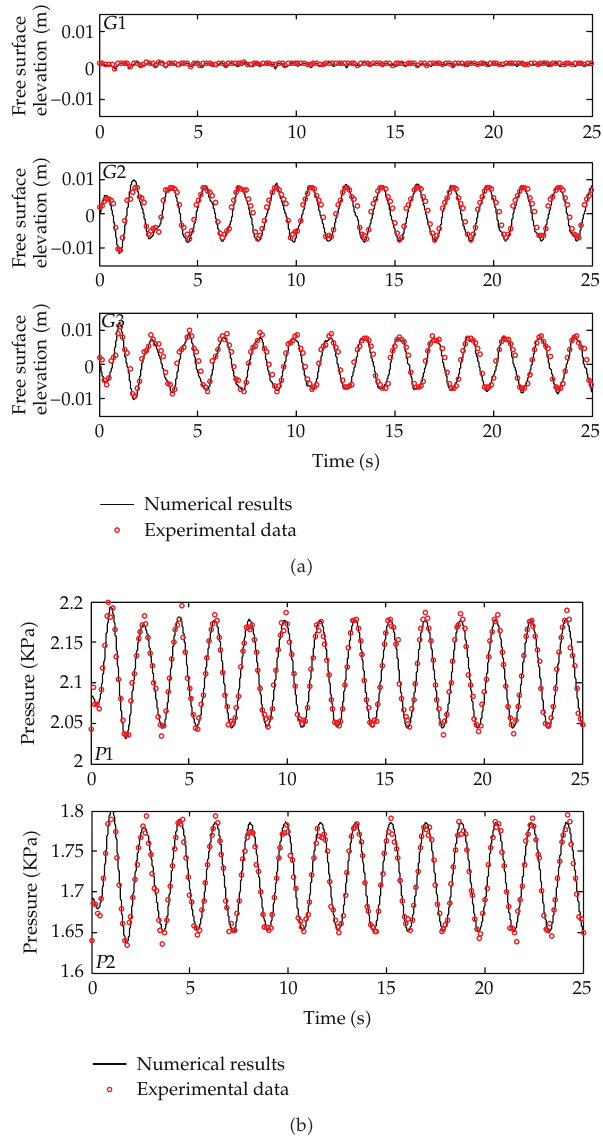
Figure 6: Comparisons of (cid:6) a (cid:7) free surface elevation at three wave gauges and (cid:6) b (cid:7) pressure at two pressure transducers between the experimental data and the numerical results for sloshing in a tank with perforated vertical ba ffl e (cid:6) x (cid:9) − a cos ωt , a (cid:9) 15mm, ω (cid:9) 0 . 5 ω 0 (cid:7)